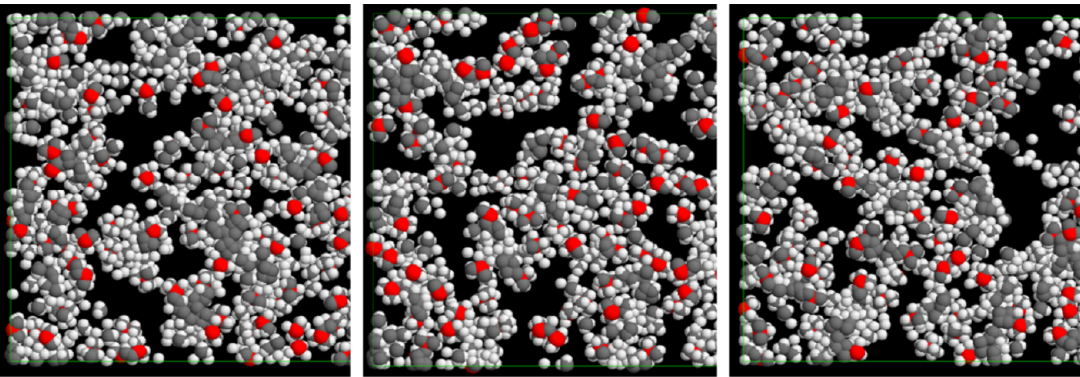
Figure 5. Visualization of free volume in PTCNSi 2 v. The density is 0.8306 g/cm 3 [15]. Successive slices in the range 0–10.5 Å.